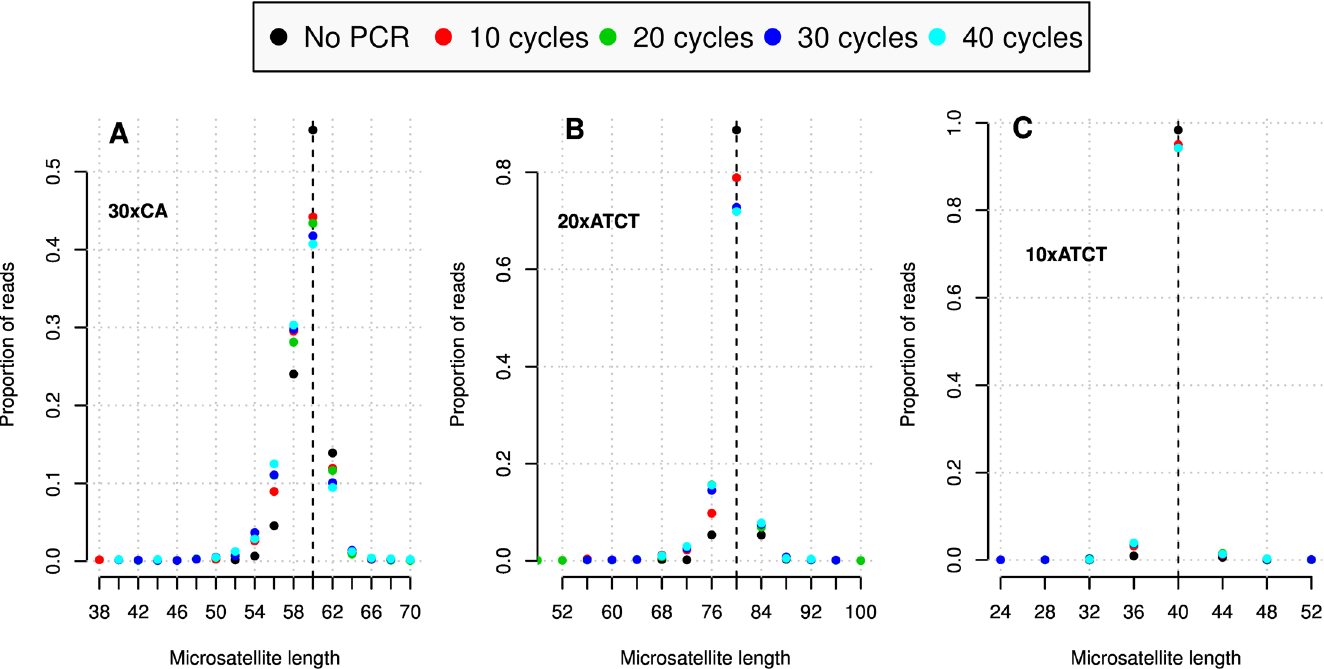
Fig 1. Mean distribution of enzyme slippage errors. Each dot in the graphs is a proportion of reads (y-axes) corresponding to the microsatellite lengths (bp) indicated on the x-axes. The dots are color coded according to the number of PCR cycles indicated above. A. Mean of two replicates of 30xCA repeat sequence. B. Mean of two replicates of 20xATCT repeat sequence. C. Mean of four replicates of 10xATCT repeat sequence. Singleton reads and reads with lengths not corresponding to multiples of the repeat units are not